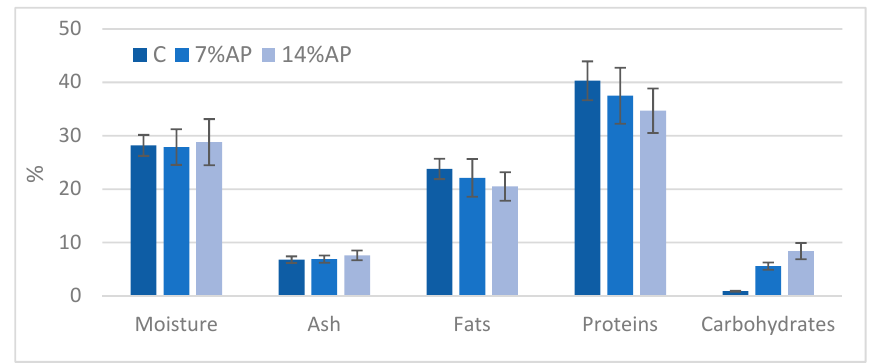
Figure 2. Proximate composition (g/100 g) of fortified salami at the end of ripening (mean values ± SD, n = 3). C, control (no added AP, 0%); 7% AP, salami with 7% added AP; 14% AP, salami with 14% added AP.